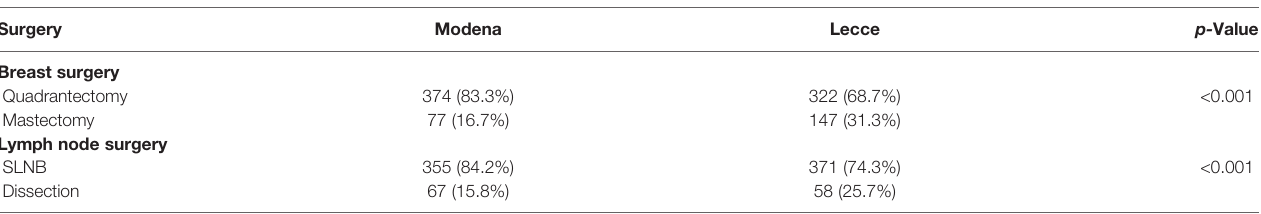
TABLE 2 | Surgical treatment of BC